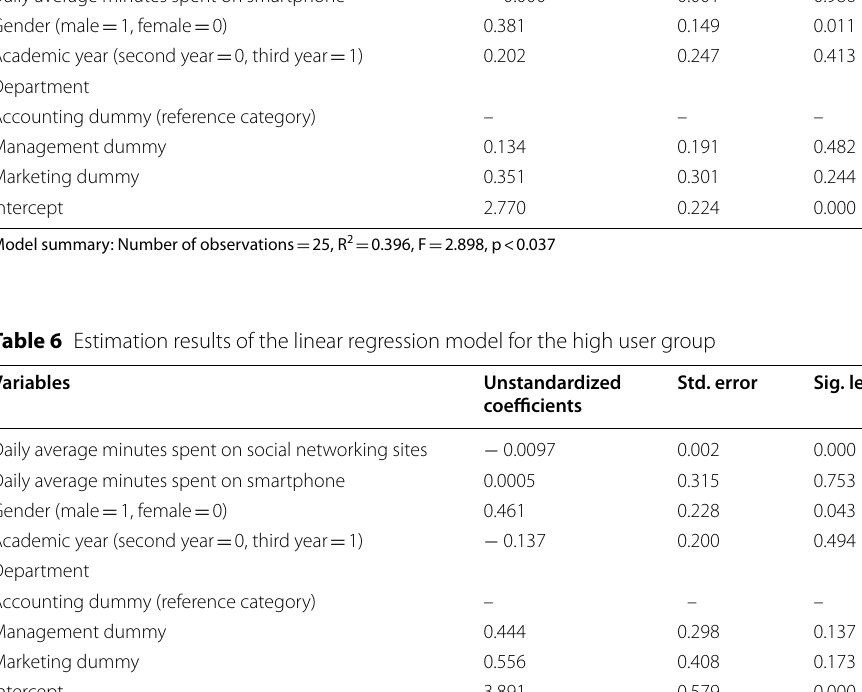
15, R 2 0.74, F 10.49, p < = = =